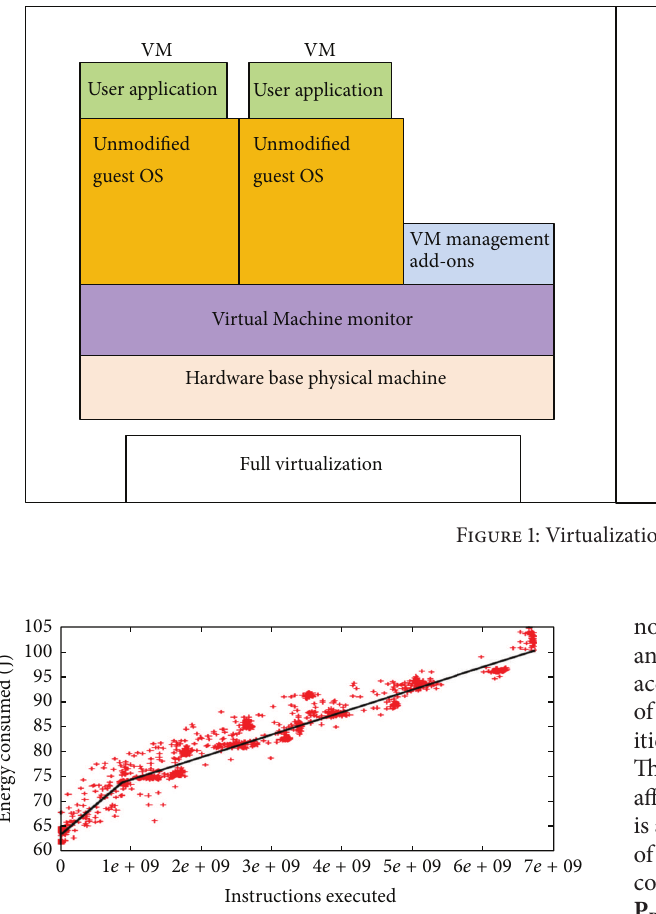
Figure 2: Power consumption depending on a number of 𝜇 Ops